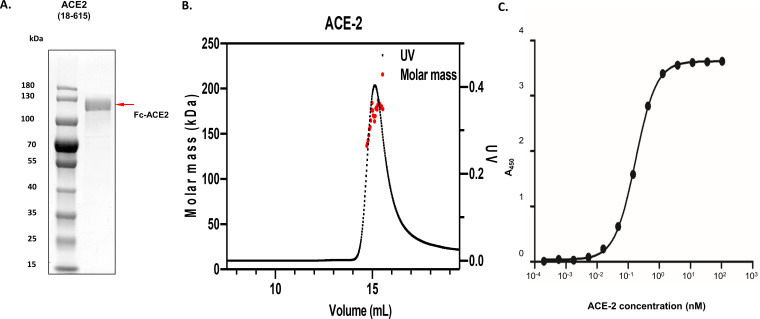
Homogeneity of angiotensin-converting enzyme 2 (ACE2) protein samples and validation of ACE2:receptor binding domain (RBD) complex formation.(A) Images of denaturing polyacrylamide gel electrophoresis of purified ACE2 (Fc-tagged) is shown, and its molecular sizes are highlighted with red arrow, alongside protein standards. (B) Molecular weight analysis of Fc-tagged ACE2 by size exclusion chromatography – multiple angle light scattering. The measured molecular weight (kDa) is 193.6 (±7.9%) for ACE2. (C) Interactions between ACE2 and RBD represented by the binding curves obtained from enzyme-linked immunosorbent assay experiments as described in 'Materials and methods'. Testing of ACE2 was performed by adding ACE2 at varying concentrations to a maxisorp plate coated with 100 µL of 27.2 nM RBD.